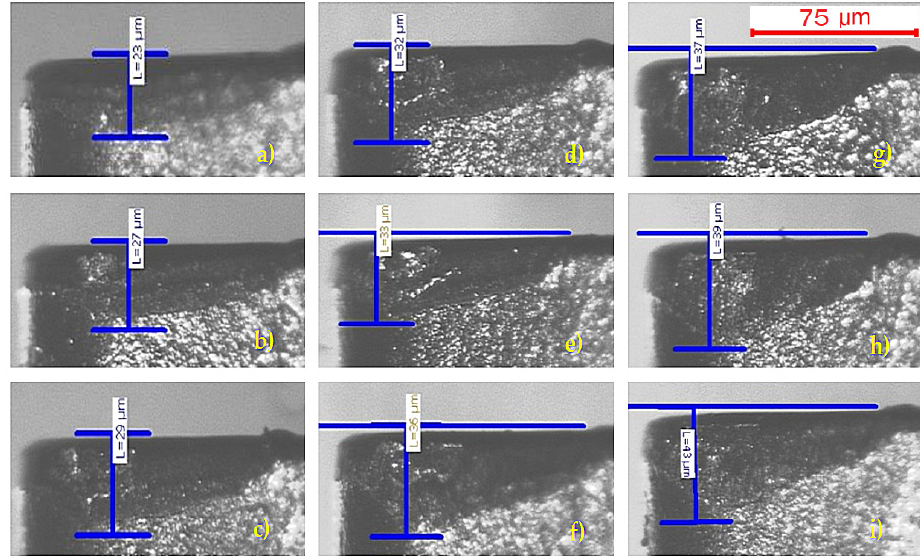
Figure 5. Exemplary wear phases of CNMG 120408E-M GRADE T9315 indexable insert depending on the cutting time T [min]: ( a ) T = 1.5, ( b ) T = 3, ( c ) T = 4.5, ( d ) T = 6, ( e ) T = 7.5, ( f ) T = 9, ( g ) T = 10.5, ( h ) T = 12, ( i ) T = 13.5.